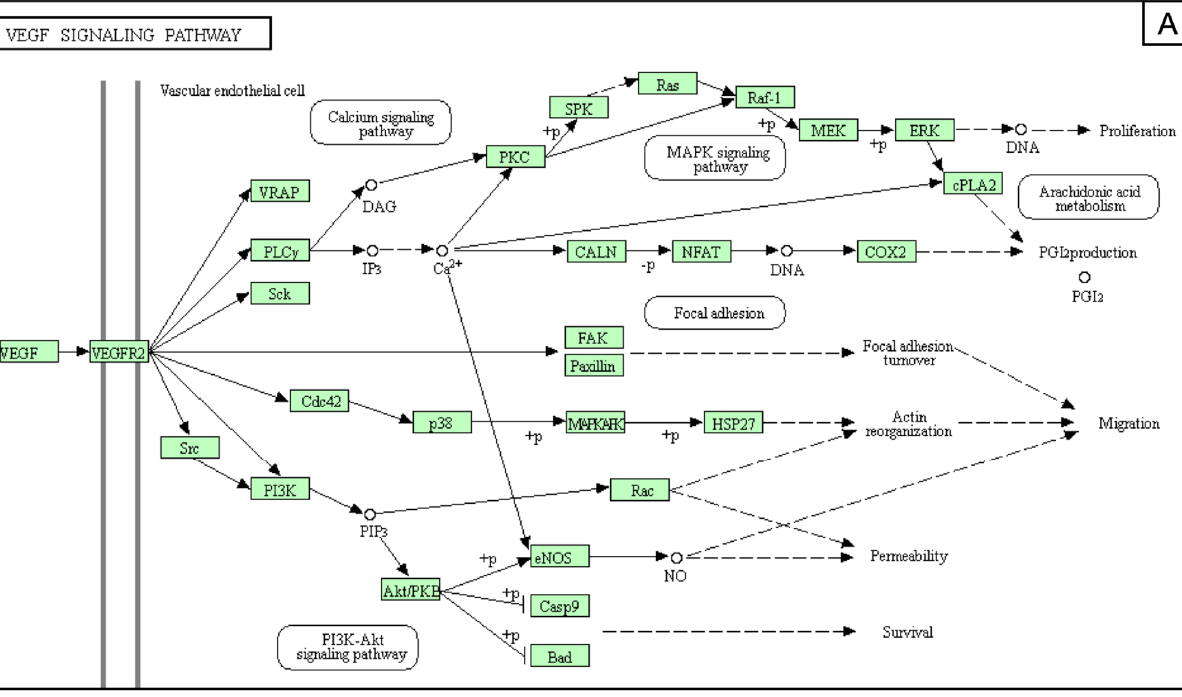
Figure 8. ( A ) VEGF regulated genes and signaling pathways. The vascular endothelial growth factor (VEGF) pathway activates several signaling pathways, which results in the upregulation of genes involved in the survival, proliferation, and migration of endothelial cells and vascular permeability. The binding of VEGF to VEGFR-2 leads to dimerization of the receptor, followed by intracellular activation of the VRAP and PLC γ , linked to the calcium signaling pathway; phosphoinositide 3- kinase (PI3K)/protein kinase D1(PDK1)/protein kinase B (Akt); and rapidly accelerated fibrosar- coma kinases (Raf)/mitogen-activated protein kinase (MAP kinase)/extracellular signal-regulated kinase (ERK) involved in DNA synthesis and cell growth. Activation of PI3K, FAK, and p38 MAPK